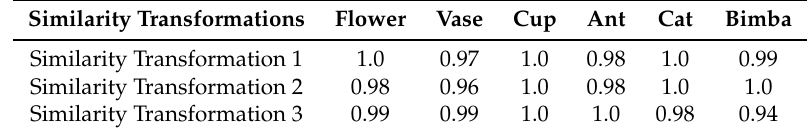
Table 10. Watermark robustness against similarity transformations measured in terms of correlation.